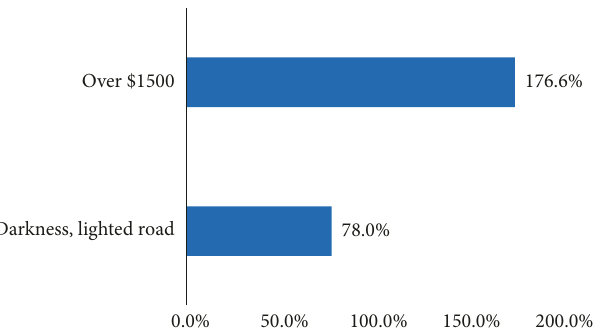
Figure 2: Percentage deviation of OR for statistically significant variables in HR and NHR Model (fatal vs. PDO crashes).